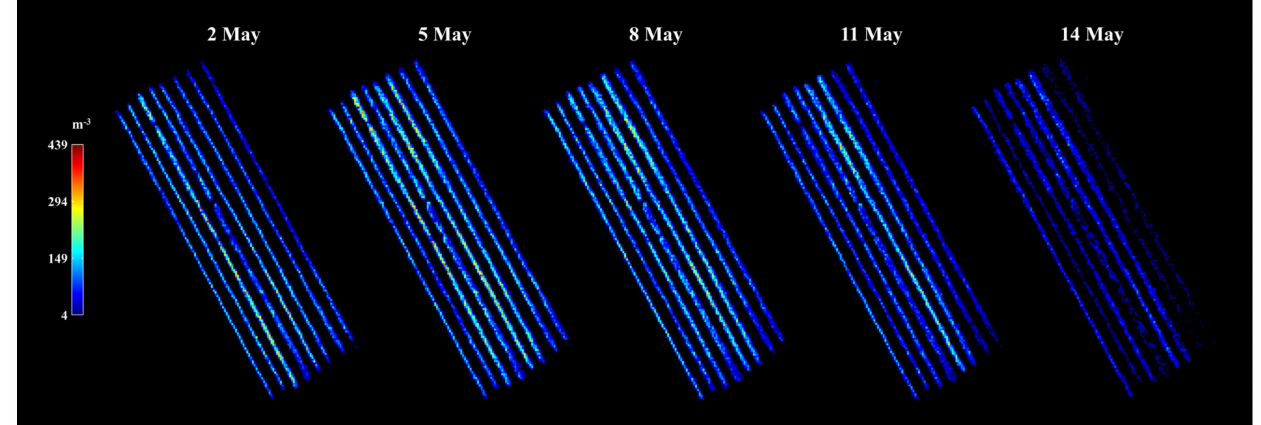
Figure 8. Blossom density maps of the field experiment apple orchard on multiple dates during the growing season of 2022 generated with a 0.3 m × 0.3 m × 0.3 m terrain grid